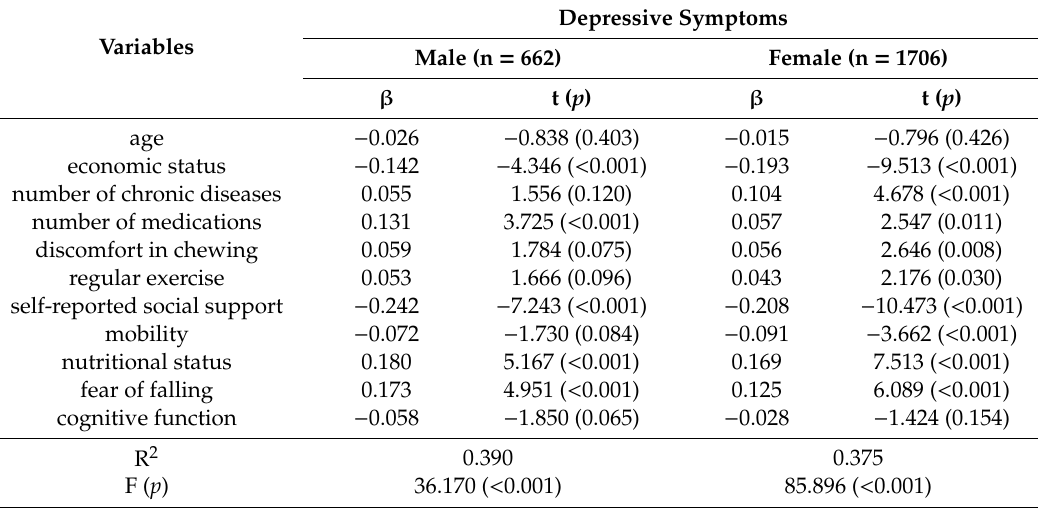
Table 4. Sex di ff erences in factors a ff ecting depressive symptoms of older people in the prefrailty phase (n =